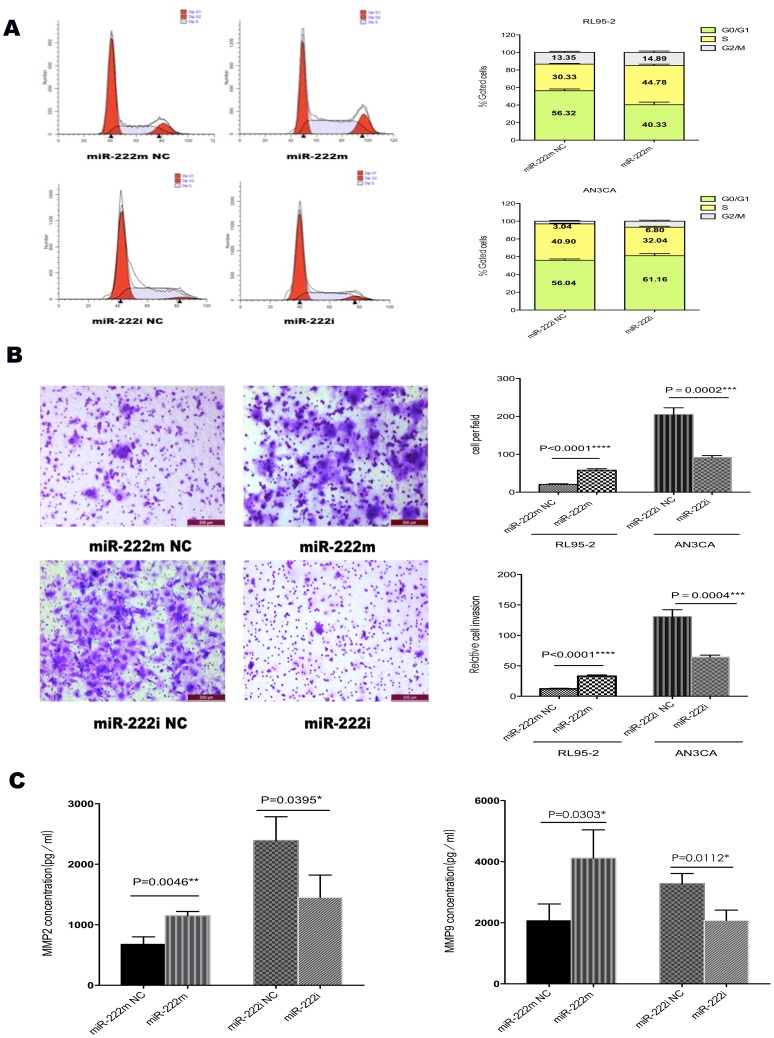
Effects of miR-222-3p on cell cycle, invasion ability and secretion of MMPs.(A) MiR-222m-transfected RL95-2 cells and miR-222i-transfected AN3CA cells were subjected to fluorescence-activated cell sorting analysis, and the relative G1, S, and G2/M compartments calculated. Data represent the average percentage of cells in each compartment in three independent experiments, each performed in triplicate. (B) Representative photos and statistical plots of transwell assays in RL95-2 cells transfected with miR-222m and miR-222m NC, and AN3CA cells transfected with miR-222i and miR-222i NC (×100). More cells traversed the transwell membrane in miR-222m transfected cells, and fewer did so in the miR-222i transfected AN3CA cell line. To exclude the effect of cell proliferation, relative cell invasion ability of RL95-2 and AN3CA cells was analyzed by normalizing relevant invasive cell numbers to 48 h MTT OD values. The results in both cells showed that high level of miR-222-3p promoted the ability of relative cell invasion. (C) MMP-2 and MMP-9 decreased significantly in cells transfected with miR-222m and increased in miR-222i transfected cells. Data are expressed as mean±SD. * P<0.05, ** P<0.01, *** P<0.001, **** P<0.0001.